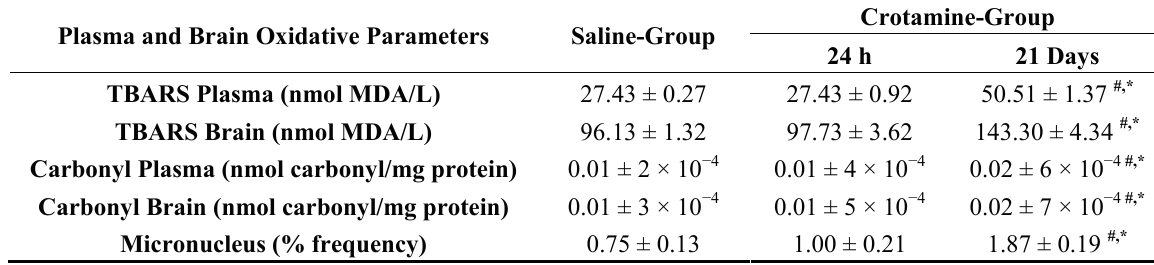
Table 2. Results of plasma and brain oxidative parameters. The intrahippocampal infusion of crotamine altered oxidative parameters 21 days later. Data are expressed as mean ±